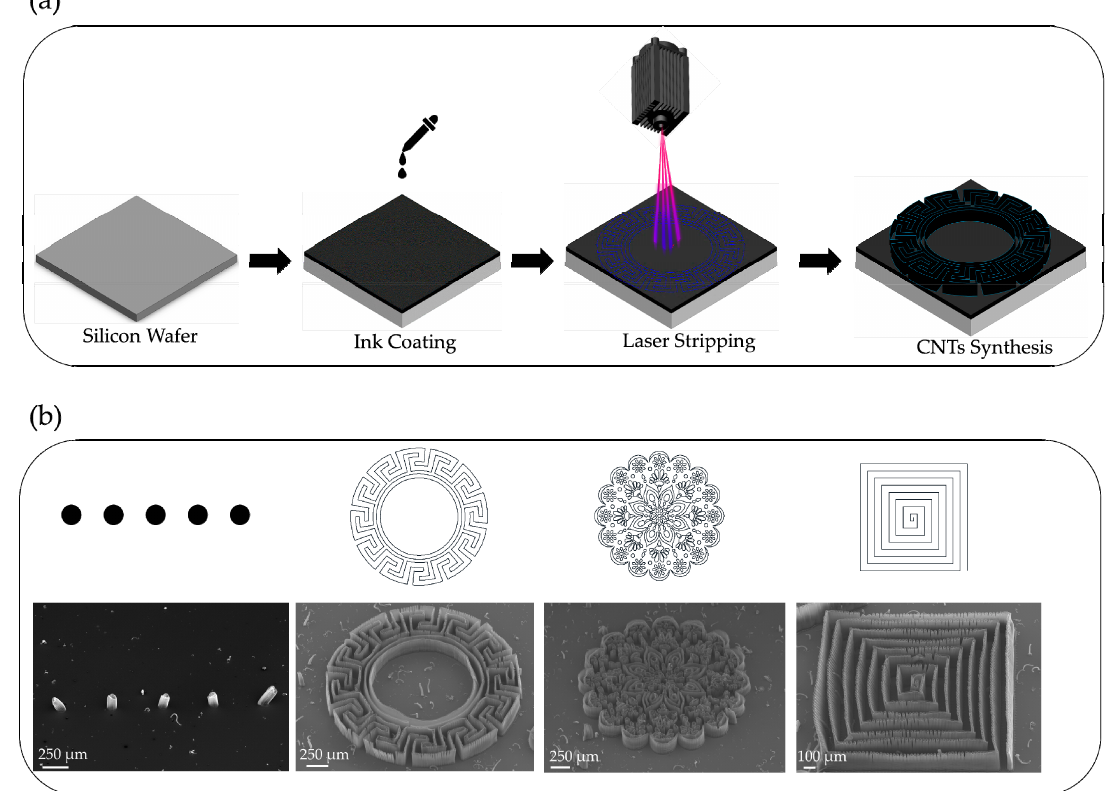
Figure 6. ( a ) The process of patterning CNT forests on a silicon wafer using laser stripping. ( b ) SEM was used to observe a synthesized CNT forest pattern with a minimum line width of 10 µm.